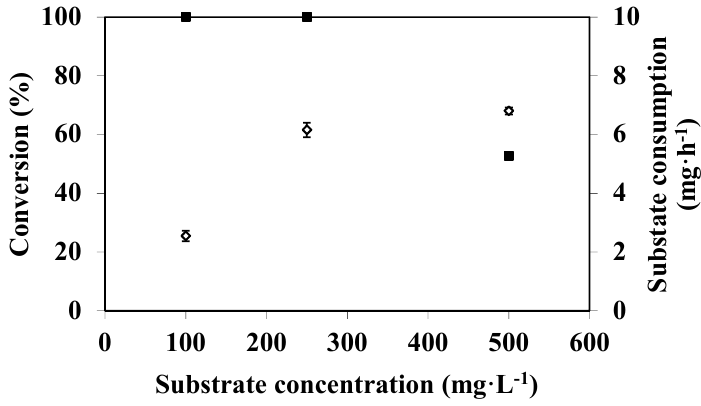
Figure 4. Substrate concentration effect on DMP degradation in an EMR used in a continuous dead-end filtration configuration (100, 250, and 500 mg·L − 1 DMP in 50 mM citrate-phosphate buffer pH 4 with 0.1 mM CuSO 4 , feed flux 11 L·h − 1 ·m − 2 , T = 40 °C, membrane pore diameter: 0.2 μ m) (substrate consumption ( ◊ ); conversion ( ■